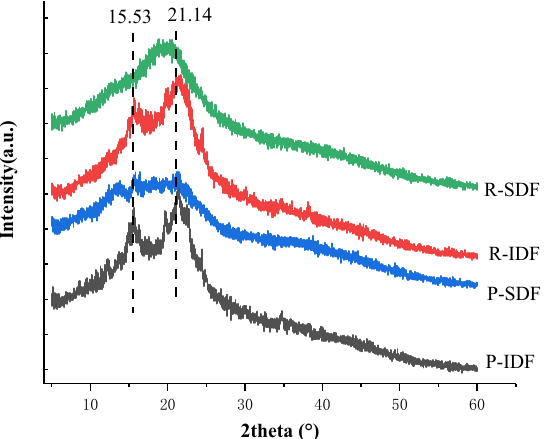
Figure 3. X-ray diffraction pattern of dietary fiber from R-SDF, P-IDF, P-SDF, R-IDF. R-SDF represents the residue soluble fiber; P-SDF represents the peel soluble fiber; R-IDF represents the residue insoluble fiber; P-IDF represents the peel insoluble fiber.